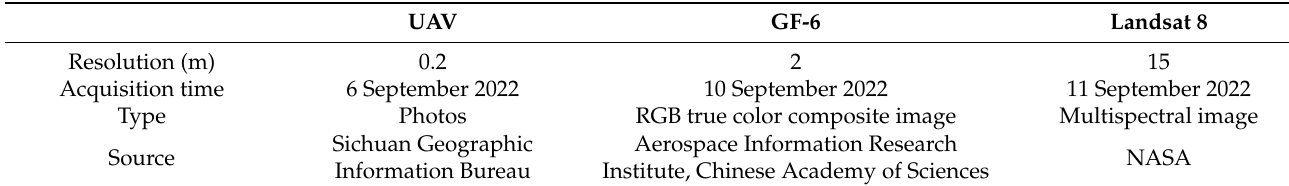
Table 1. Basic parameters of remote sensing image.